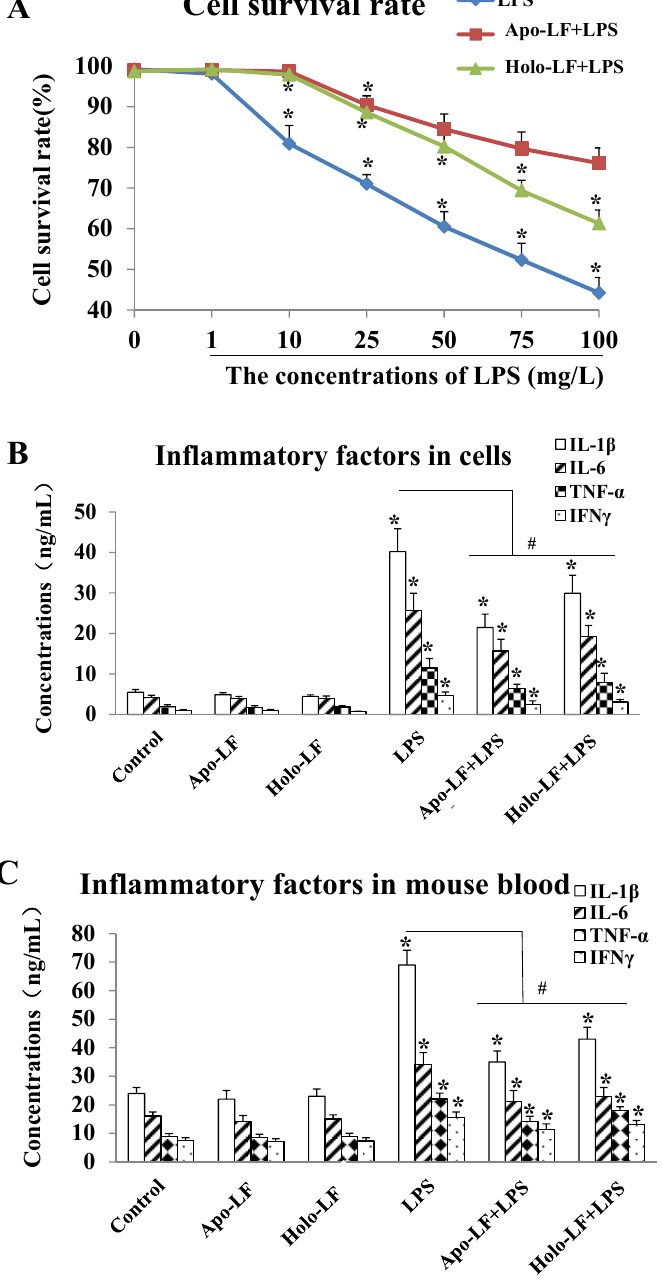
Figure 2. Lactoferrin with different iron saturations (Apo–LF or Holo–LF) protects mouse primary intestinal epithelial cells and young mice from LPS–induced inflammatory injury. ( A ) The cell survival rate of the LPS–induced mouse primary intestinal epithelial cells treated with saline, Apo–LF and Holo–LF; ( B ) The expression levels of inflammatory factors in the mouse primary intestinal epithelial cells with different interventions; ( C ) The expression levels of inflammatory factors in the serum of the young mice with different interventions. n = 3 mice per group. Data represent mean ± SD. * p < 0.05 by Student’s t test and # p < 0.05 by one–way ANOVA analysis.